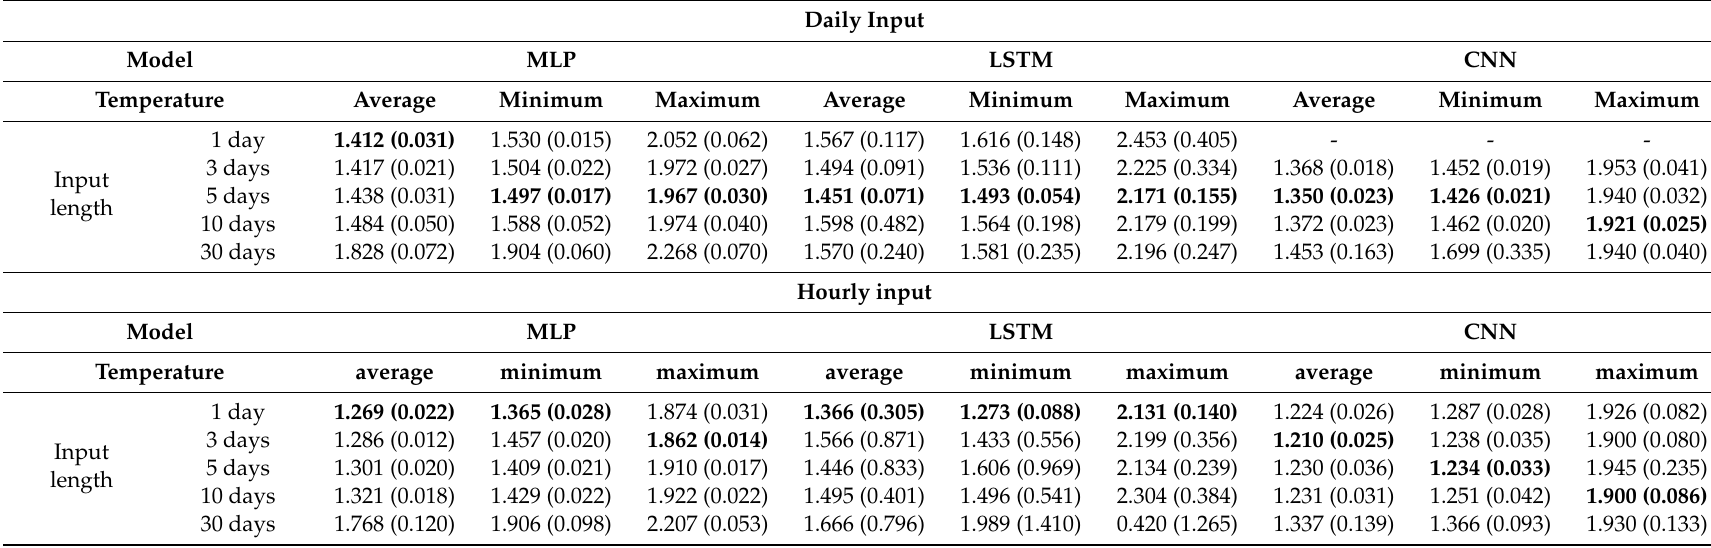
Table 17. Forecasting results, represented using the MAE, for coastal area